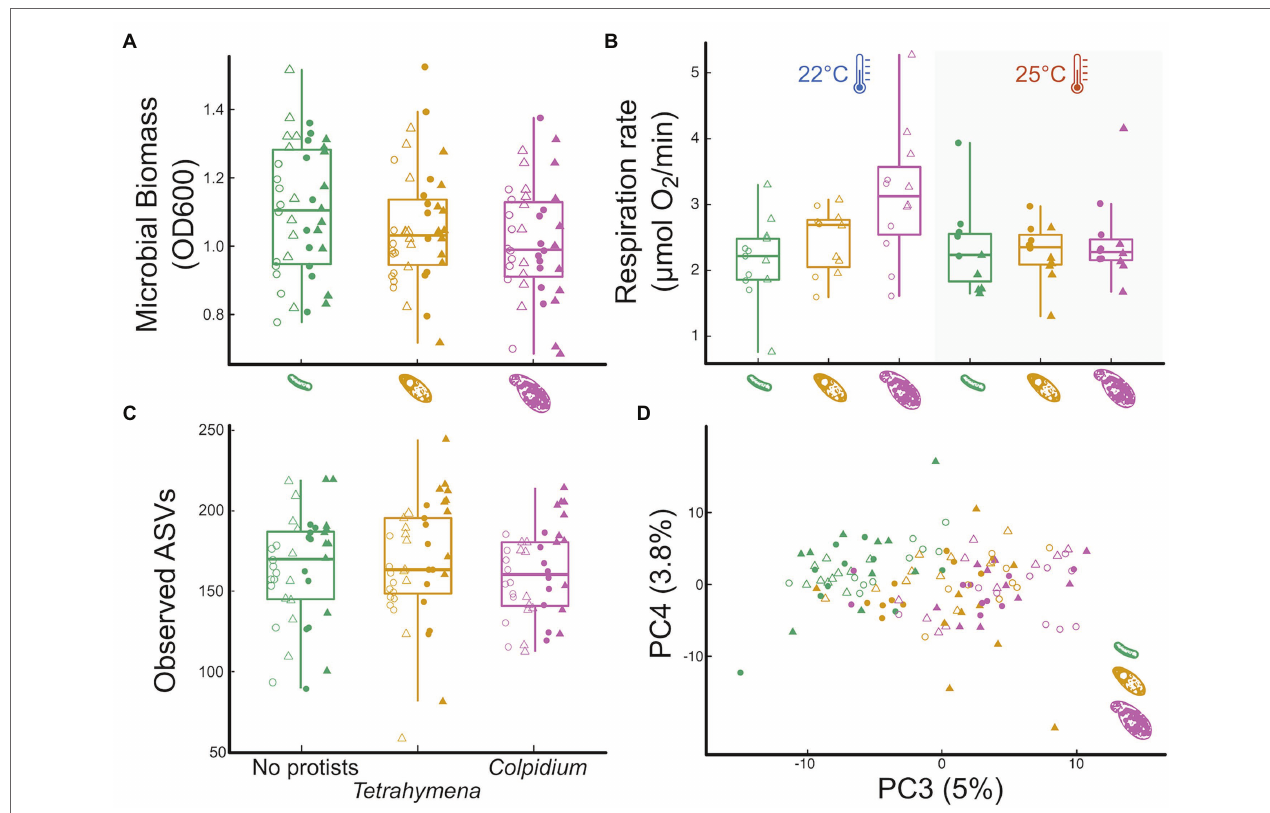
FIGURE 2 | Influence of protist presence and species on pond microbial community function and community structure. The effect of the absence of protists (green), Tetrahymena (yellow) or Colpidium (fuchsia) on: (A) optical density (600 nm) as a proxy for total microbial biomass, (B) total microbial respiration (O2 consumption rate), (C) microbial community richness (observed ASVs; see Supplementary Figure S6 for other diversity indices), and (D) a principal component analysis of microbial community structure. Shapes represent incubation time: Day12—circles, Day 24—triangles; temperature marked by point fill: 22 ° C—empty point, 25 ° C—color filled